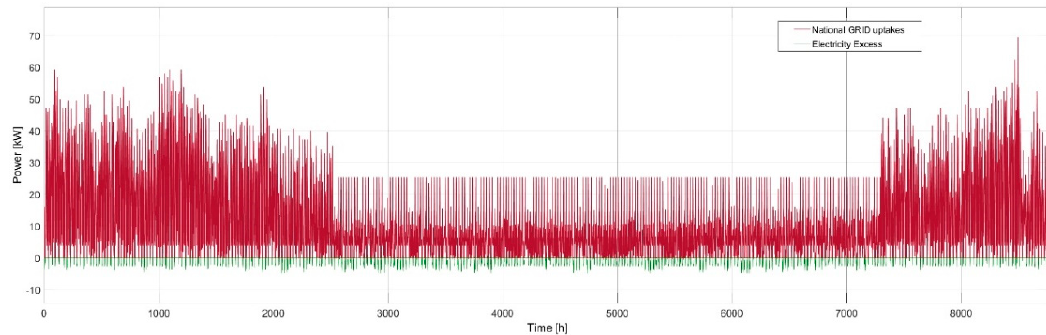
Figure 8. Electrical demand and electricity excess (in red the amount of energy purchased in one year